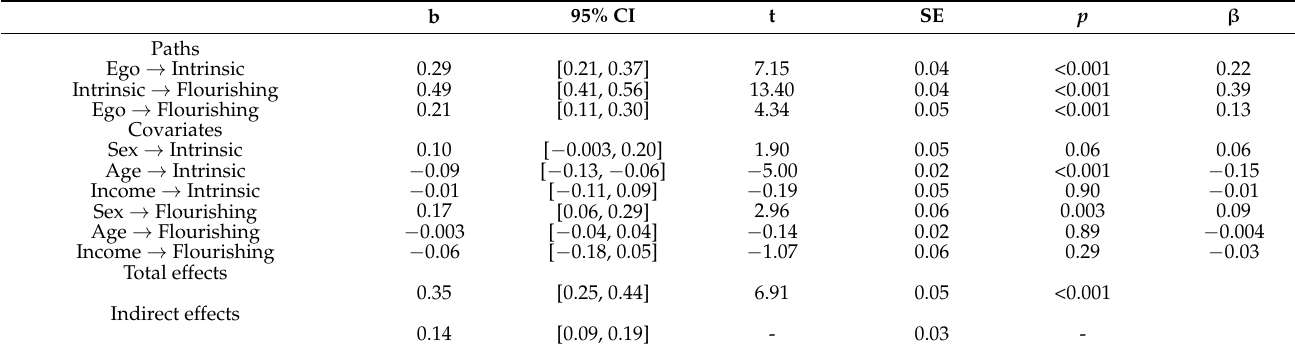
Table 2. Associations between ego identity exploration, intrinsic motivation and flourishing (N = 995). b